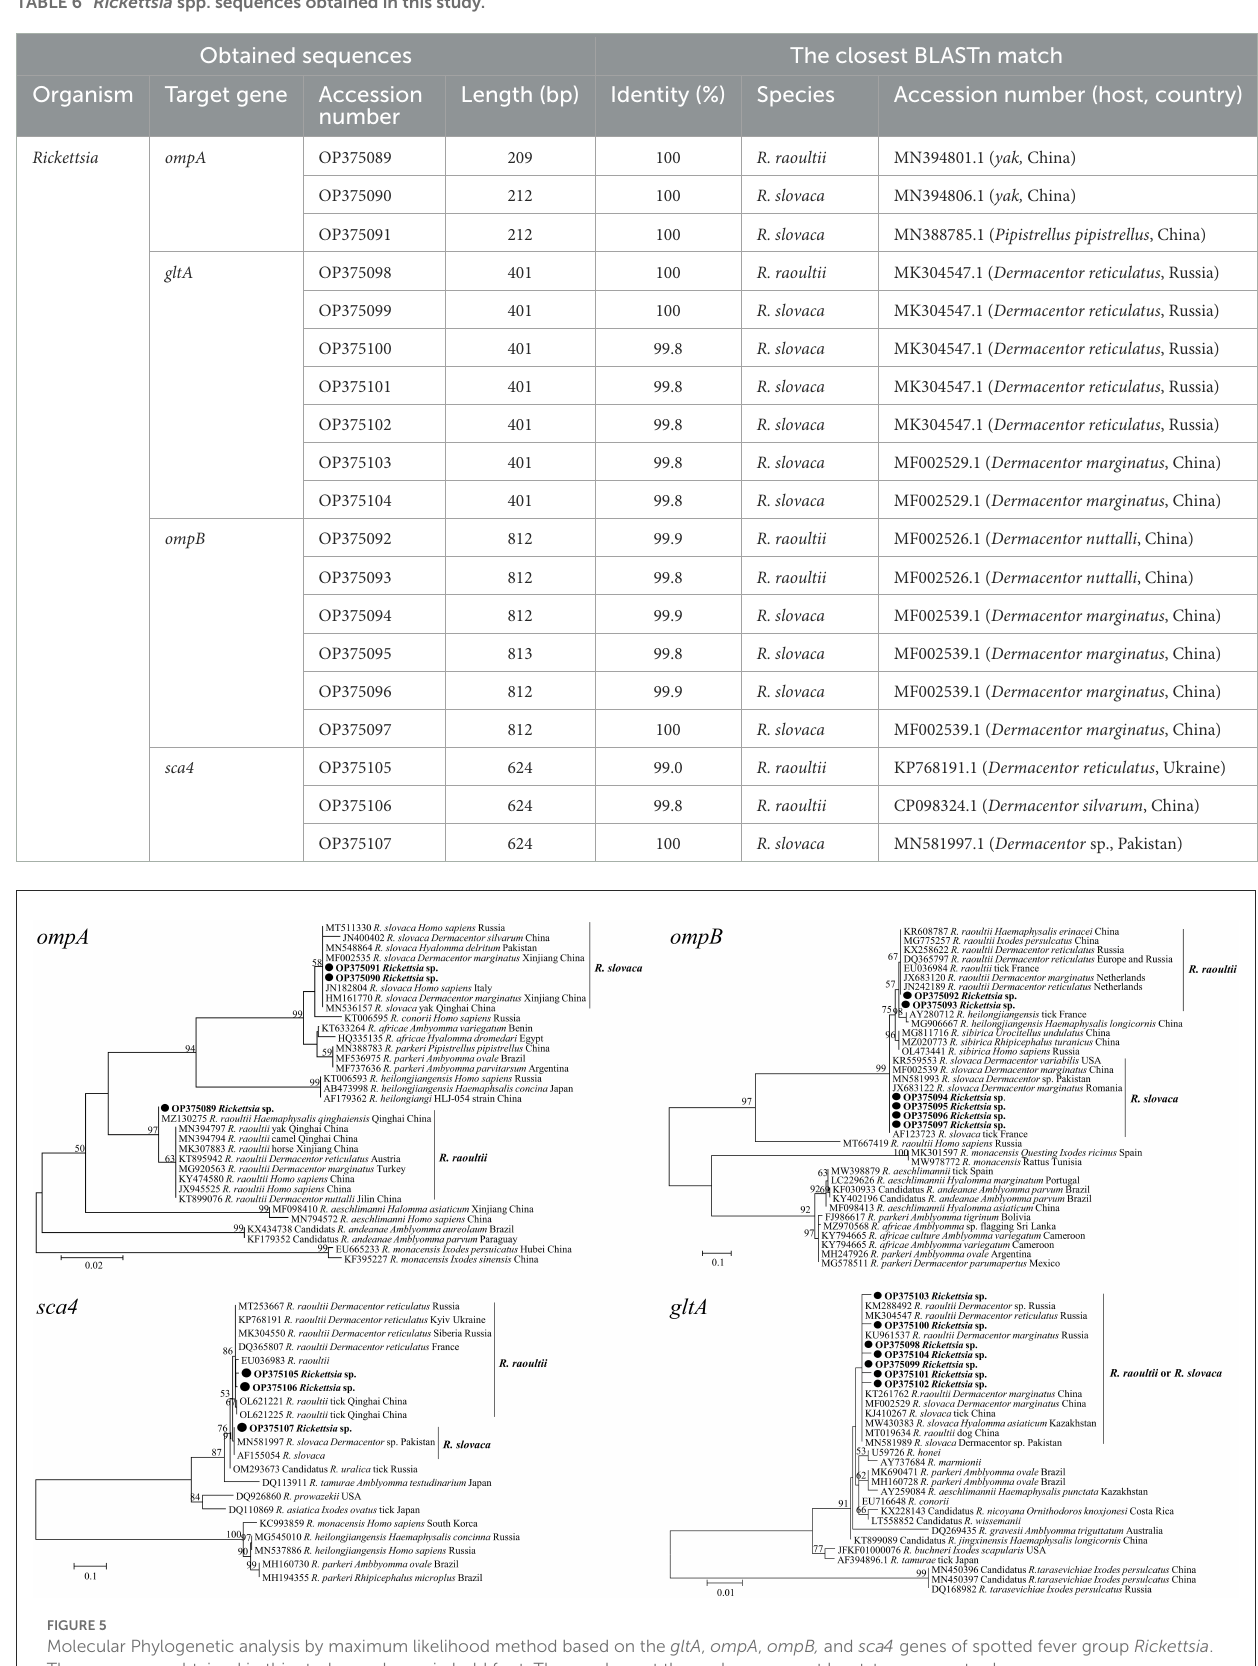
TABLE 6 Rickettsia spp. sequences obtained in this study.